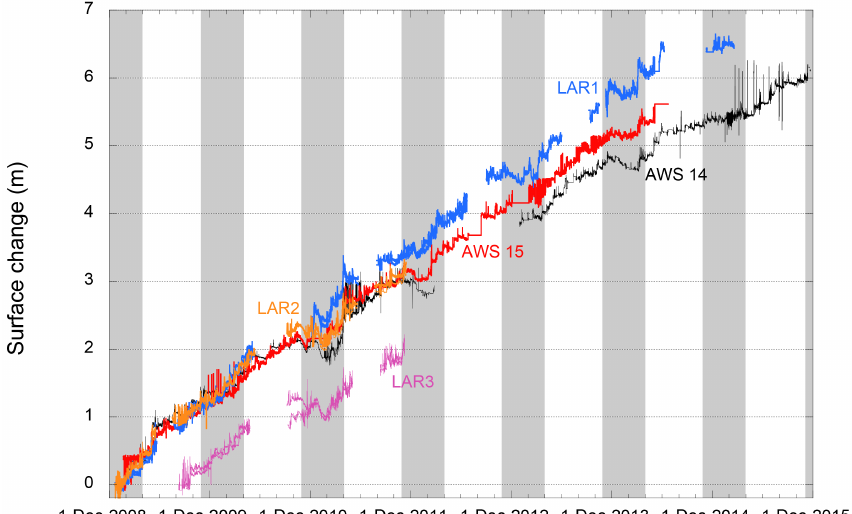
Figure 3. Complete, filtered time series of cumulative surface height change (m) recorded with sonic height rangers at five locations. LAR1, 2, and 3 were equipped with two sonic rangers, plotted in the same colour. Grey bars indicate the summer season used in this paper (1 November–31